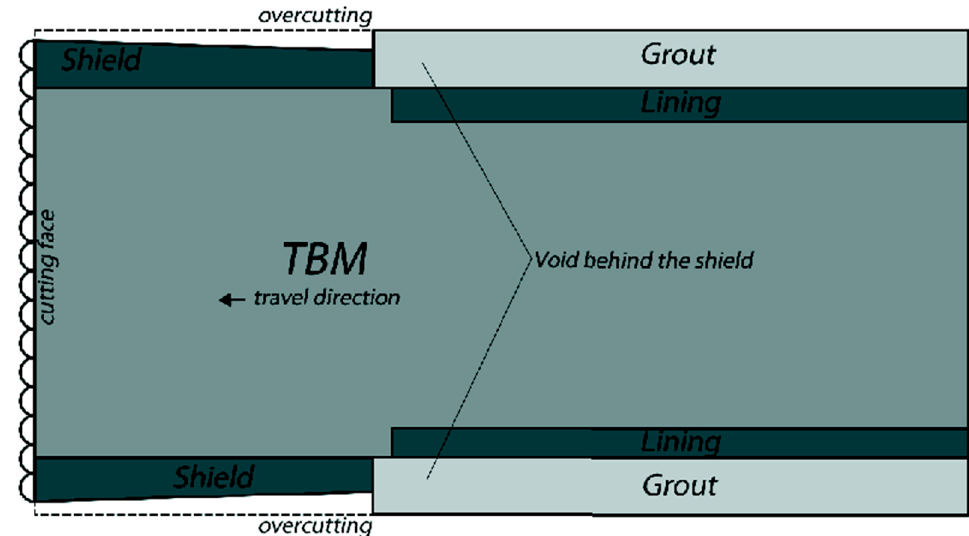
Figure 1. Schematic diagram of a TBM indicating overcu tt ing (not to scale).